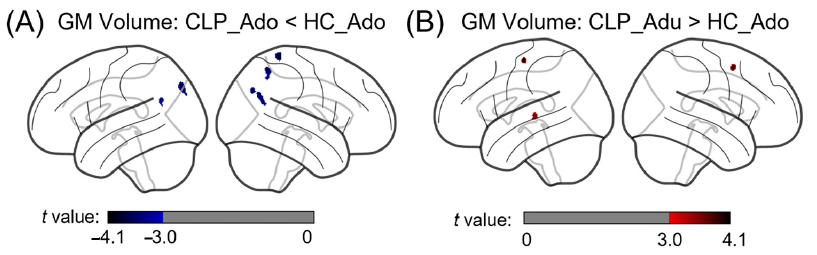
Figure 1. Grey matter (GM) volume with significant group differences between CLP and HC. ( A ) Anatomical locations of clusters with signi fi cant group di ff erences, the GM volume of which was signi fi cantly decreased in CLP adolescents compared to HC adolescents in the volume-based mor- phometry analyses; ( B ) anatomical locations of clusters with signi fi cant group di ff erences between CLP and HC adults—the volume within these regions was signi fi cantly increased in CLP adults compared to HC adults. Gender, age and total intracranial volume (TIV) were regressed out as co- variates, and signi fi cance was set at cluster-wise Gaussian theory fi eld (GRF)-corrected p < 0.05. CLP_Adu = adults with cleft and palate (CLP), HC_Adu = healthy control adults, CLP_Ado = chil- dren and adolescents with CLP, HC_Ado = healthy children and adolescents.